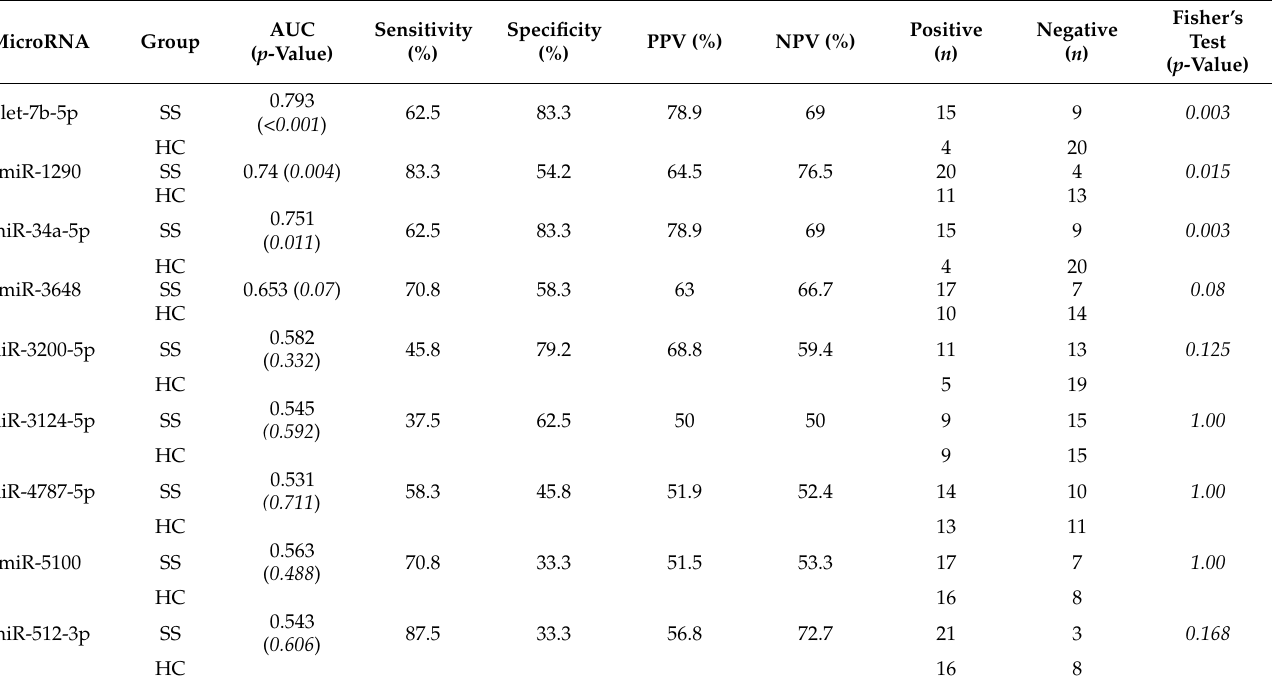
Table 2. Diagnostic performance of miRNAs for Sjögren syndrome (SS) detection using cut-off